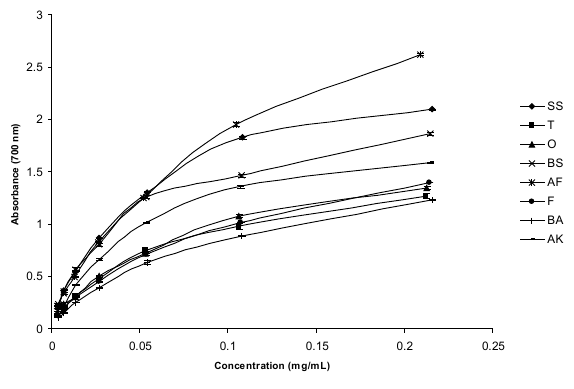
Figure 2 : Reducing power of flower essential oils from Ammoides pusilla collected in diverse regions of Algeria. For collection places code, see Table 1.